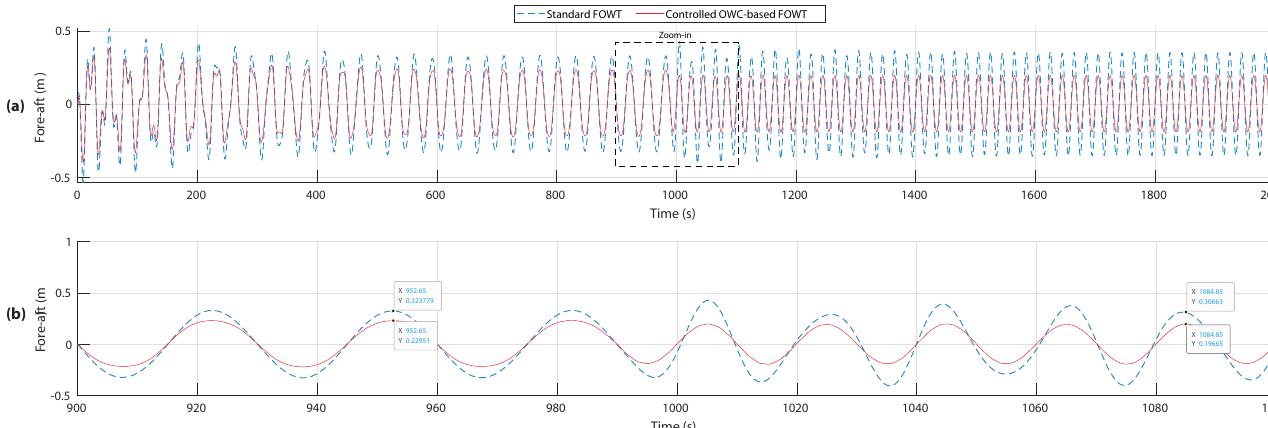
Figure 10. Obtained tower fore-aft displacement in both structures. ( a ) Tower fore-aft displacements. ( b ) Zoom-in of the tower fore-aft